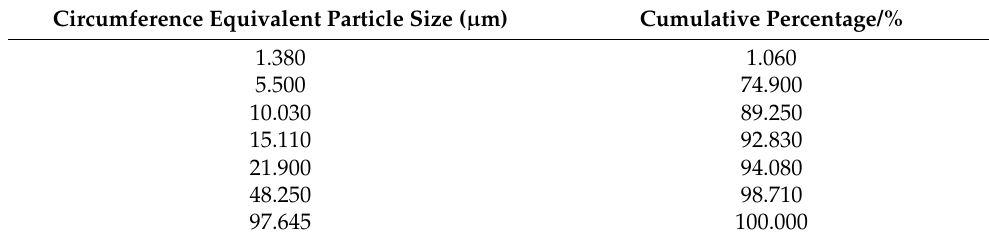
Table 1. Particle size distribution analysis results.